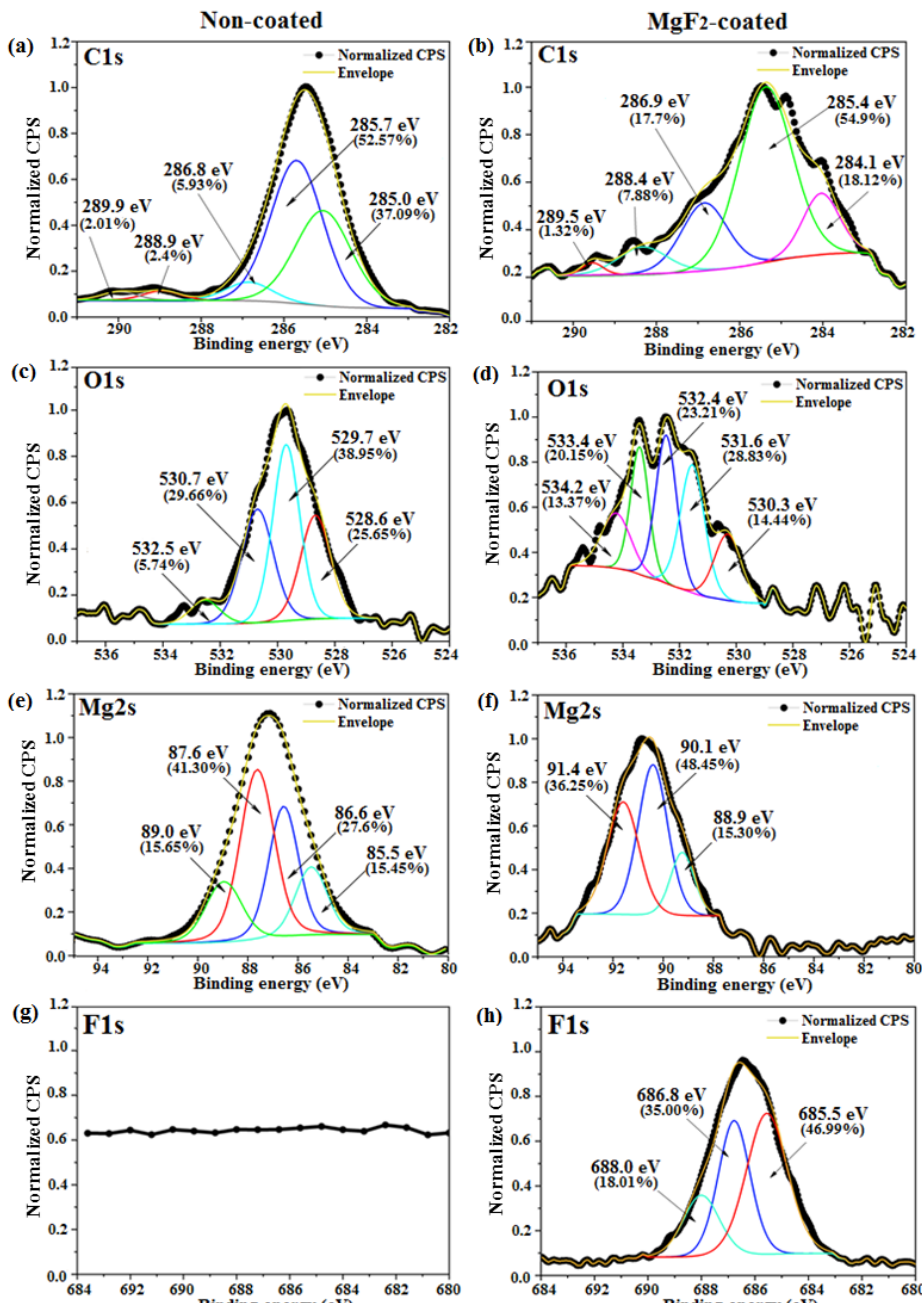
Figure 8. High-resolution spectra of C1s ( a , b ), O1s ( c , d ), Mg2s ( e , f ), and F1s ( g , h ) of non-coated and coated samples, respectively.